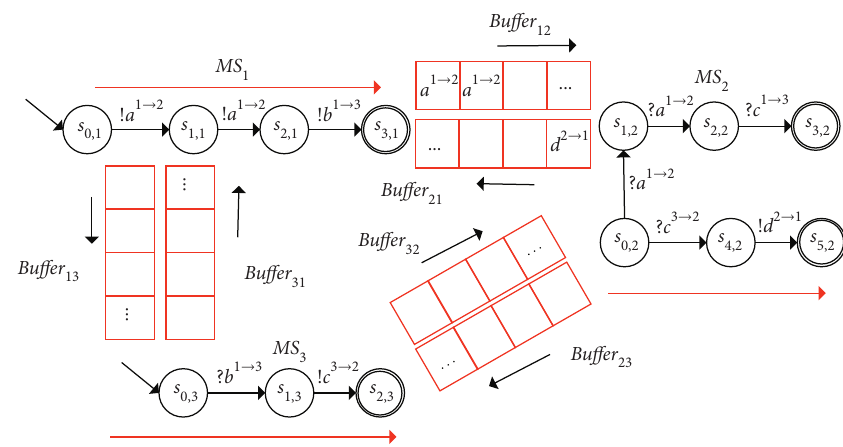
Figure 5: A snapshot of a microservice system in c